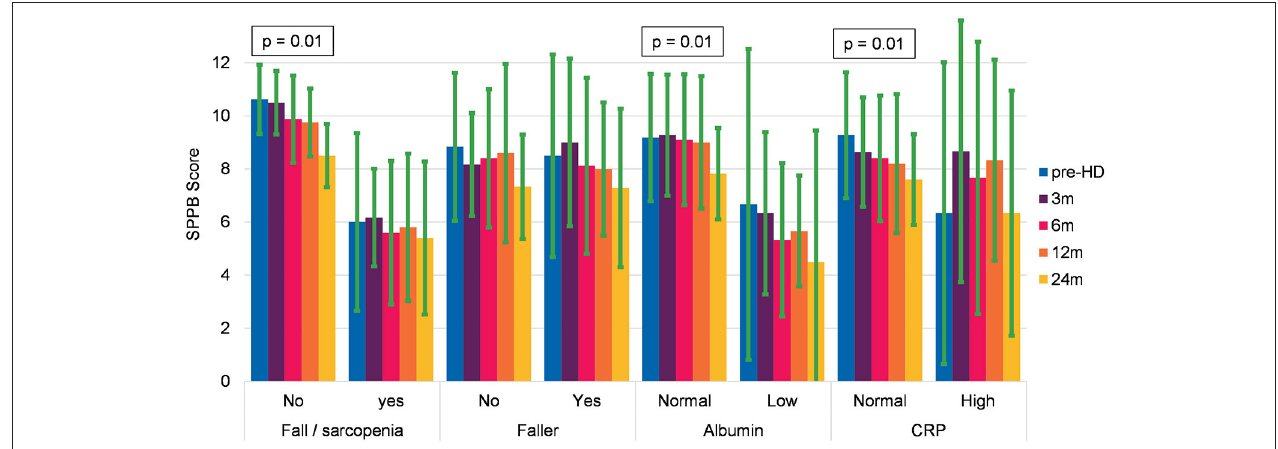
FIGURE 3 | Evolution of the SPPB in relation to frailty and inflammatory status at baseline (mean and